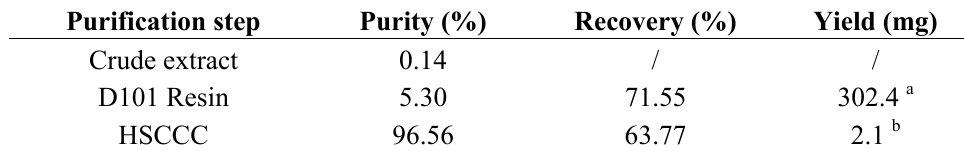
Table 4. The purities and recoveries of poncirin in the two-step